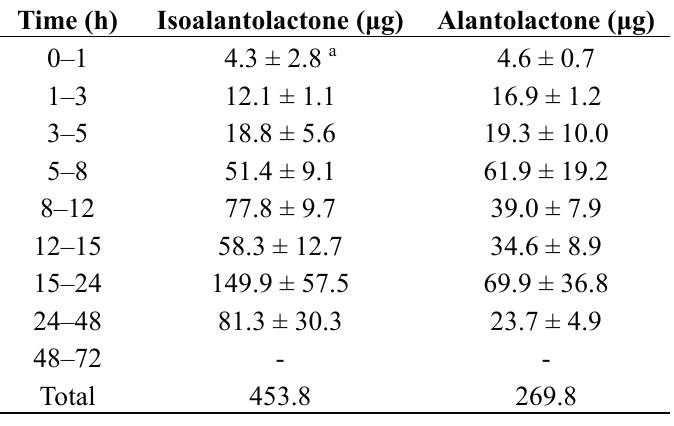
Table 5. Excretion of lactones in rats bile after a single oral administration at 90 mg/kg.